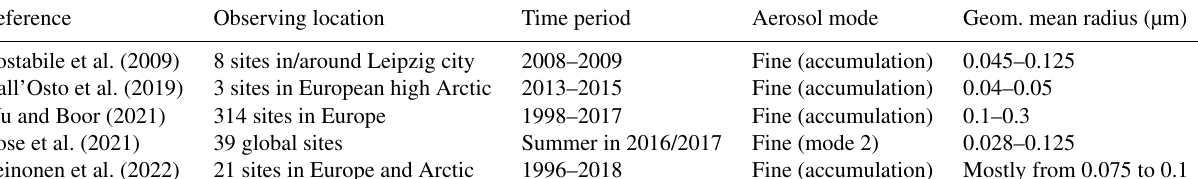
Table 5. Summary of published observed lognormal size distribution parameters over Europe.